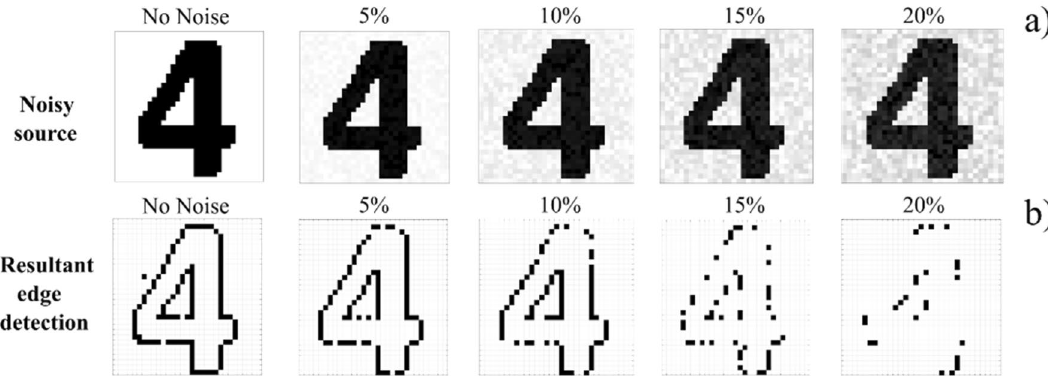
Figure 4. Influence of source image noise on the edge-detection performance of the VCSEL neuron system. Noise is introduced to the printed “Digit 4” source image via the random variation of global pixel intensity (a,b) . Global pixel intensity is varied randomly up to